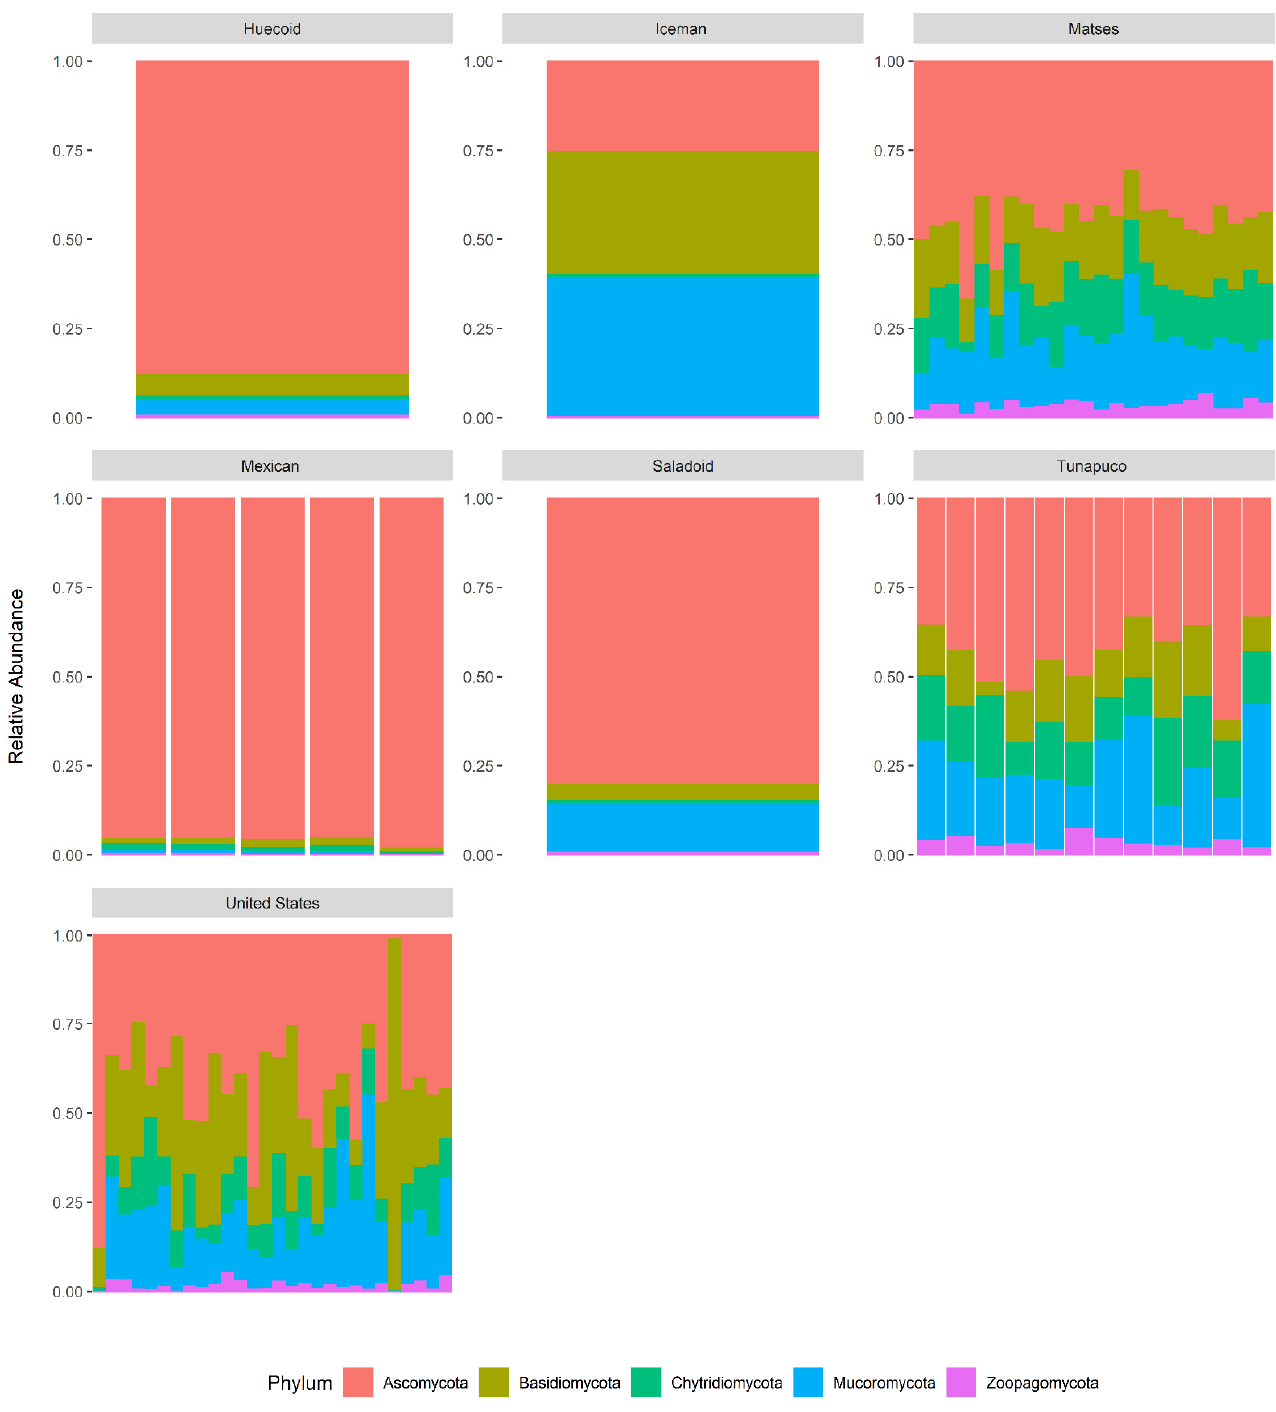
Figure 6. Gut mycobiome composition at the phylum level, relative abundance of all fungal phyla detected in the gut mycobiome of the ethnic groups.